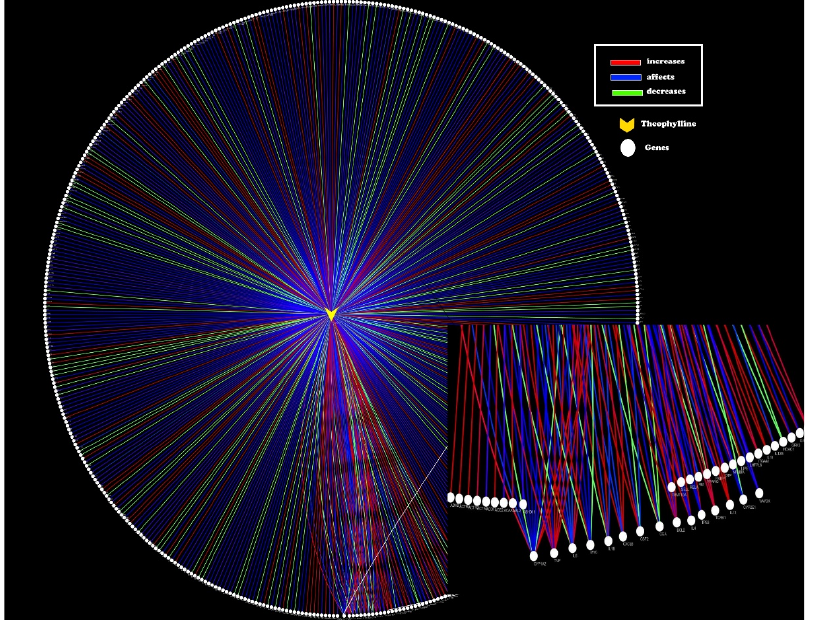
Figure 2. Pharmacological network biology analysis of theophylline ‐ genes interaction. Node in yellow represents theophylline and white nodes represent genes that are modified to different degrees: somehow affected (blue), increased (red) or decreased activity (green) according to the Comparative Toxicogenomics Database [45].